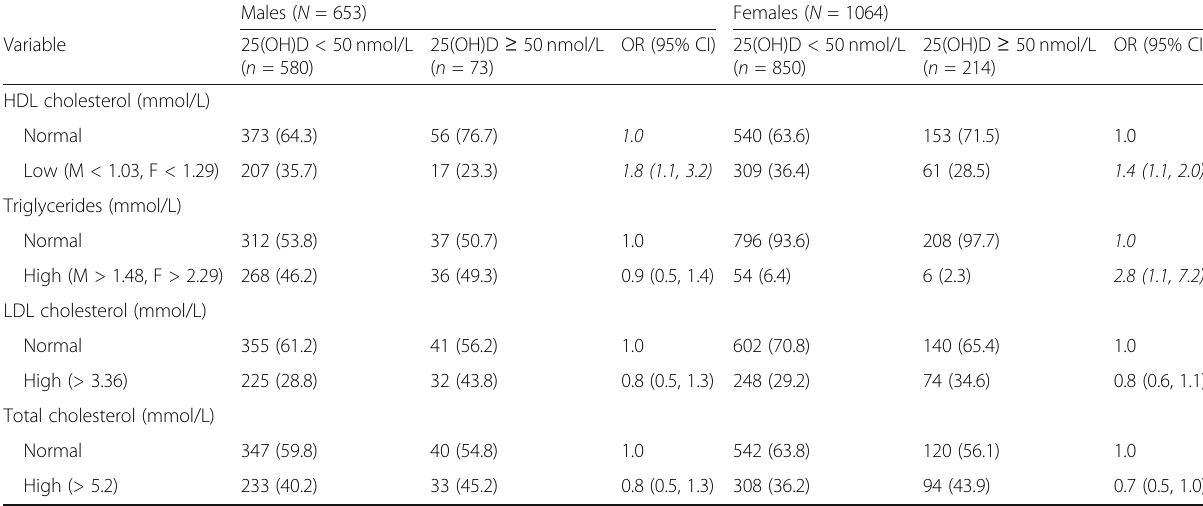
Table 3 Bivariate analysis showing unadjusted odds ratio and 95% CI between lipid profile and low vitamin D in Saudi male and female participants in Riyadh, Saudi Arabia